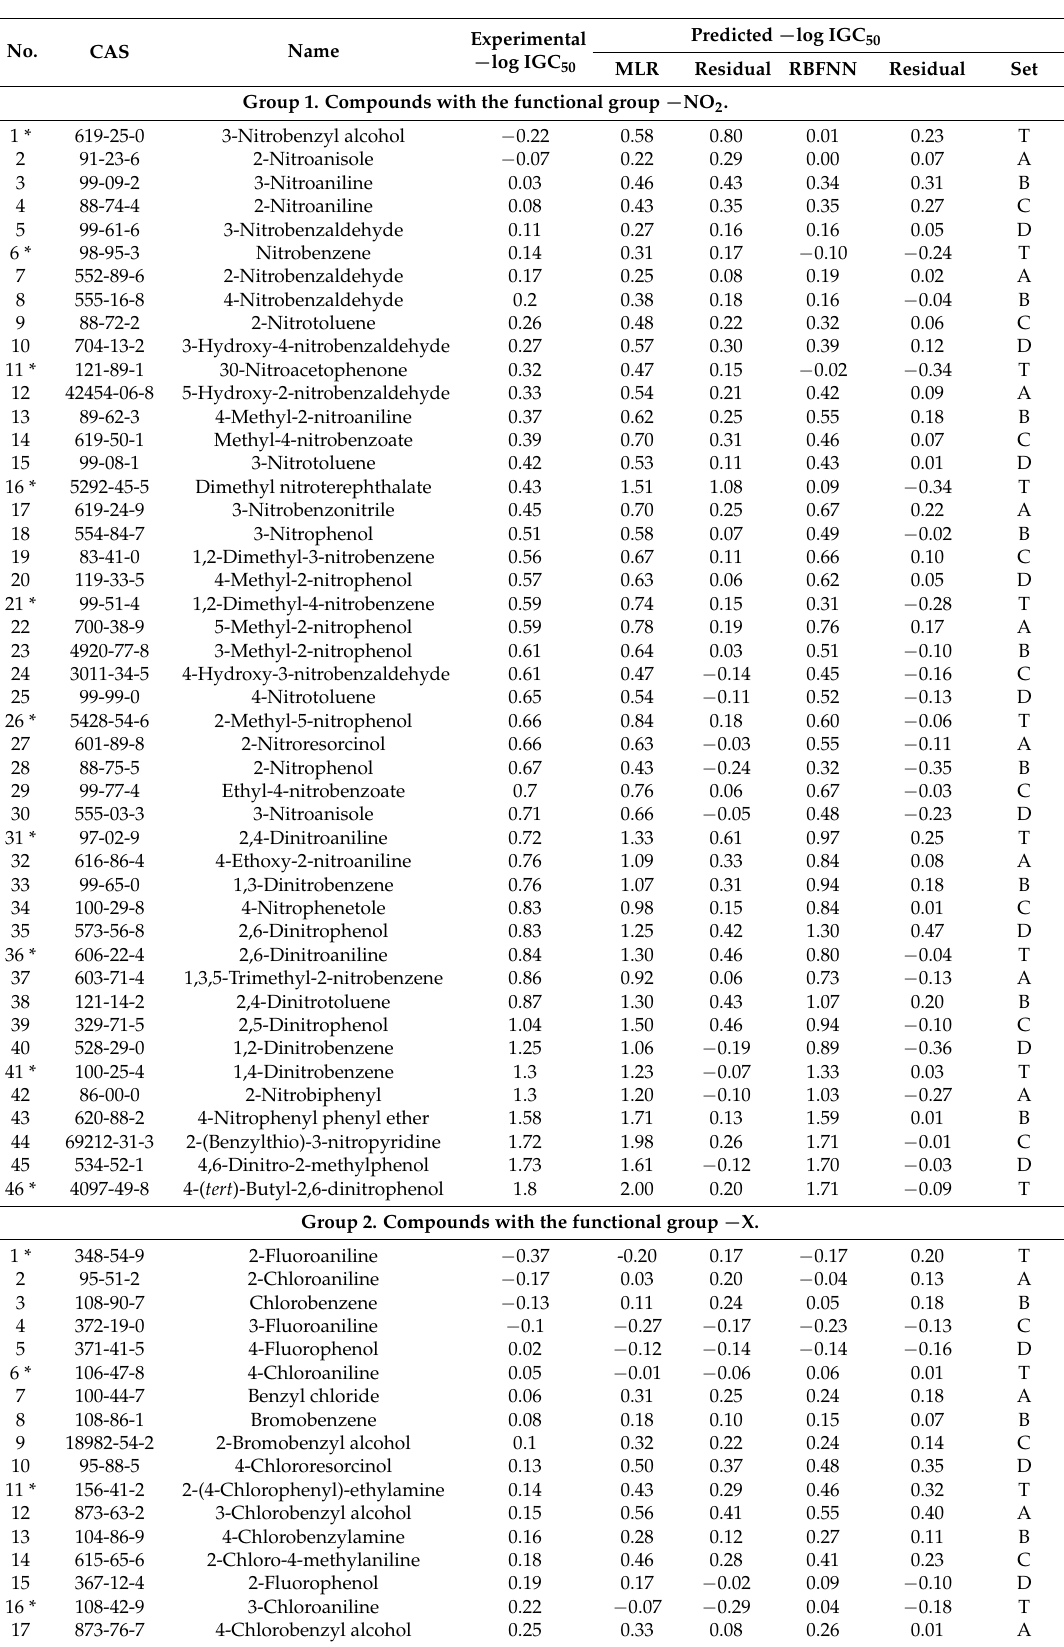
Table 1. The CAS number, name, experimental − log IGC 50 values, predicted − log IGC 50 values and their corresponding residual for the three groups of